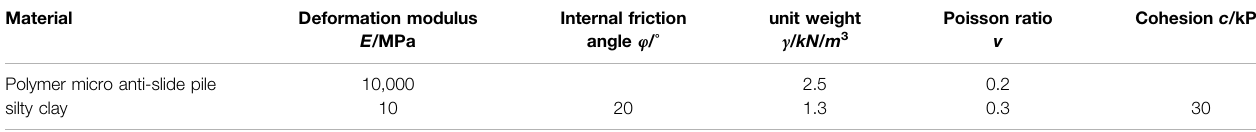
TABLE 1 | Mechanical parameters of soil and pile.